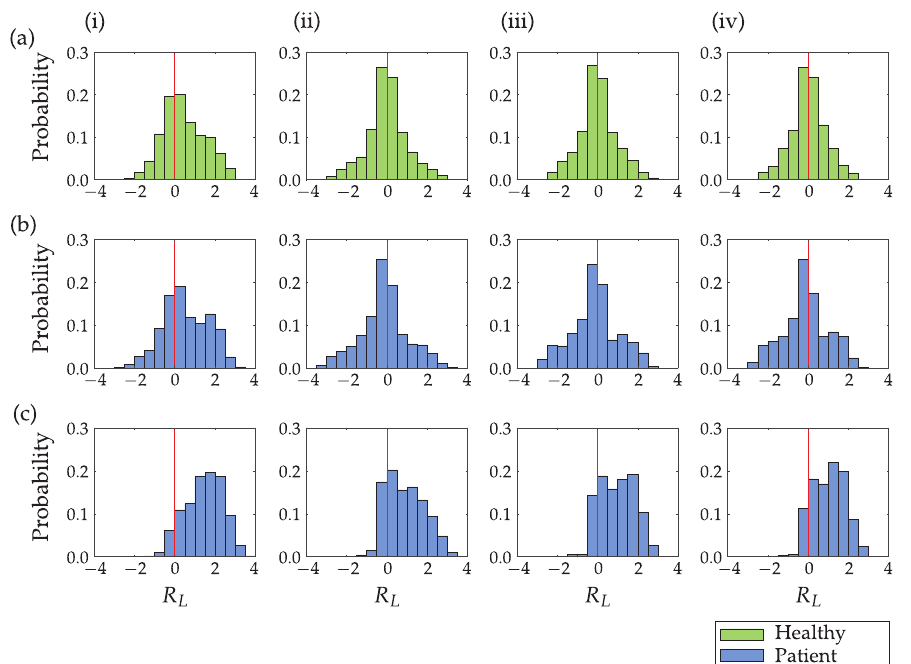
Figure 10. The natural logarithm of the ratio of the hand path lengths of the unaffected (dominant) upper limb and the affected (non-dominant) upper limb for different segmentation methods: path- based segmentation ( i ), and time-based segmentation into one ( ii ), three ( iii ) and five ( iv ) second movement periods for a healthy person ( a ) and two patients after stroke ( b , c ). The red vertical line marks the boundary between the unaffected (dominant) and affected (non-dominant) upper limb.